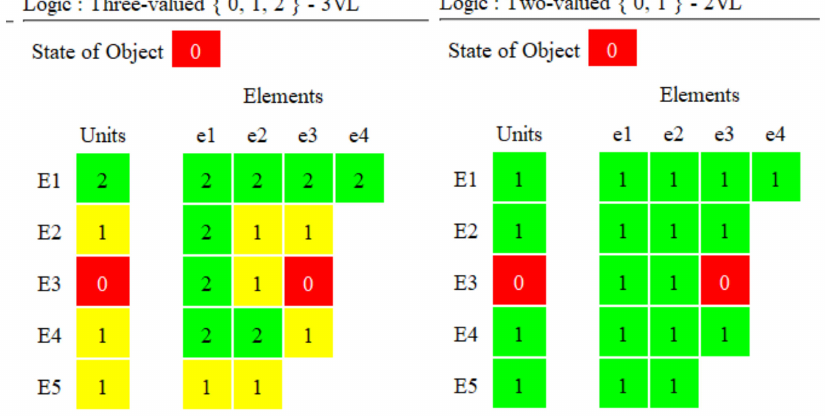
Figure 13. Screen of comparative analysis of the state assessment of L-PSPD in the DIAG 2